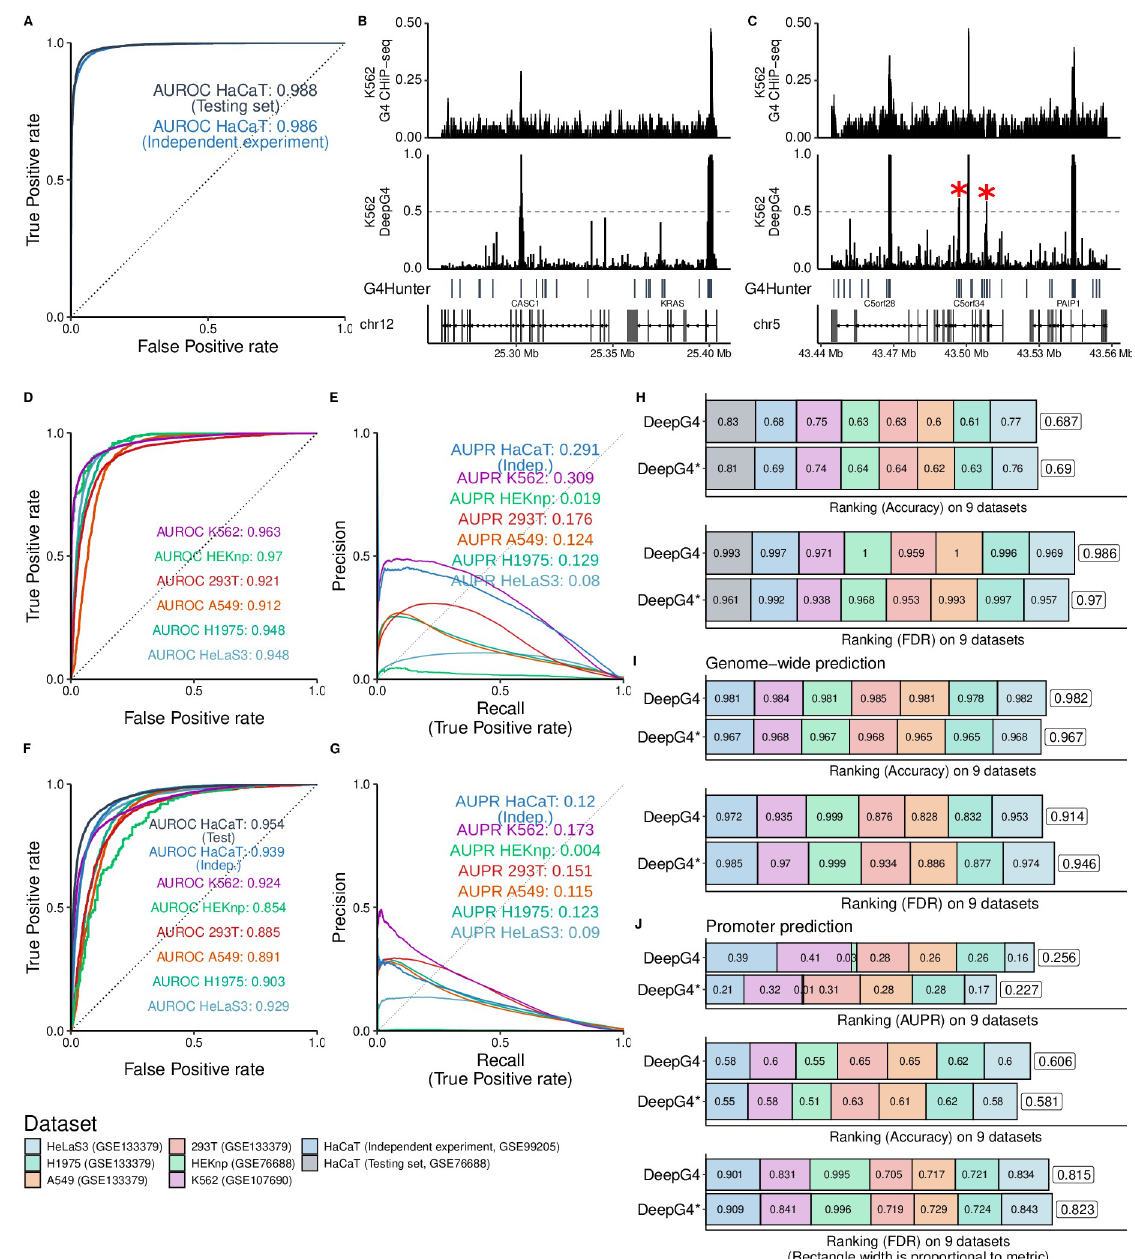
Fig 3. Prediction performance of DeepG4 to predict active G4 regions (regions where G4s form both in vitro and in vivo). A) Prediction performance of DeepG4. The model was trained and evaluated using HaCaT cell data. Predictions were evaluated on the testing set of sequences (same experiment as training set), but also on an independent set of sequences (from a different ChIP-seq experiment). Receiver operating characteristic (ROC) curve and area under the ROC curve (AUROC) were plotted. B) Genome browser of HaCaT-trained DeepG4 predictions and G4 ChIP-seq around KRAS gene in K562 cells. C) Genome browser of HaCaT-trained DeepG4 predictions and G4 ChIP-seq around C5orf34 gene in K562 cells. D) Prediction performance of DeepG4 trained using HaCaT data and evaluated on other cell lines. E) Genome-wide prediction performance of DeepG4 trained using HaCaT data and evaluated on other cell lines. Predictions are computed for every 200-b bins of the genome. Area Under the Precision-Recall curve is plotted (AUPR). F) Prediction performance of DeepG4 � trained using HaCaT data and evaluated on other cell lines. DeepG4 � is identical to DeepG4 except that chromatin accessibility is not used as input. G) Genome-wide prediction performance of DeepG4 � trained using HaCaT data and evaluated on other cell lines. H) Comparison of DeepG4 and DeepG4 � prediction performances, in terms of accuracy and false discovery rate (FDR) metrics. I) Comparison of DeepG4 and DeepG4 � genome-wide prediction performances, in terms of accuracy and false discovery rate (FDR) metrics. J) Comparison of DeepG4 and DeepG4 � promoter prediction performances, in terms of AUPR, accuracy and false discovery rate (FDR) metrics.